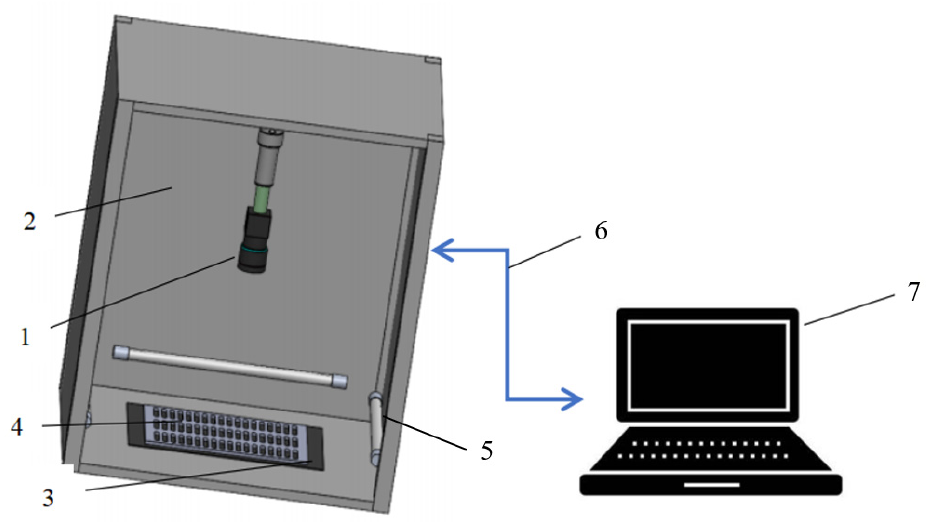
Figure 1. Wheat seed image acquisition device. 1. USB camera. 2. Dark box. 3. Light-absorbing fabric. 4. Sampling hole plate. 5. strip light sources. 6. Cable. 7. Computer.